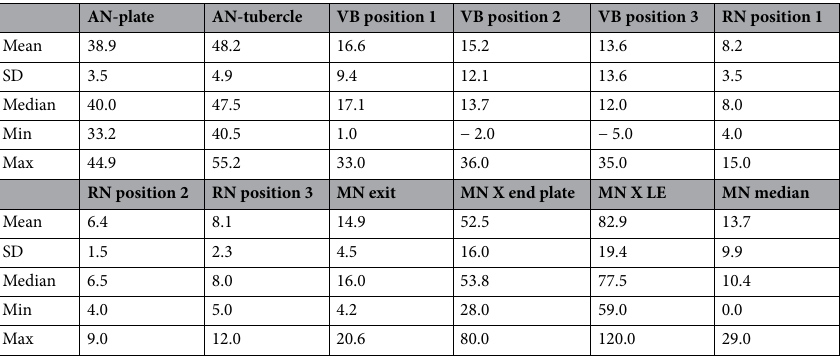
Table 1. Measurements in neutral position ( in mm ). AN-plate AN to proximal margin of the plate, AN-tubercle AN to tip of greater tubercle, VB medial vascular bundle for respective position, MN exit exit of MN from coracobrachialis, MN X end plate intersection point of the MN and the plate measured from the distal margin of the plate, MN X LE intersection point of the MN and the plate measured from the LE, MN median measurement point at the middle of the exit and intersection points, SD standard deviation, min minimum, max maximum.